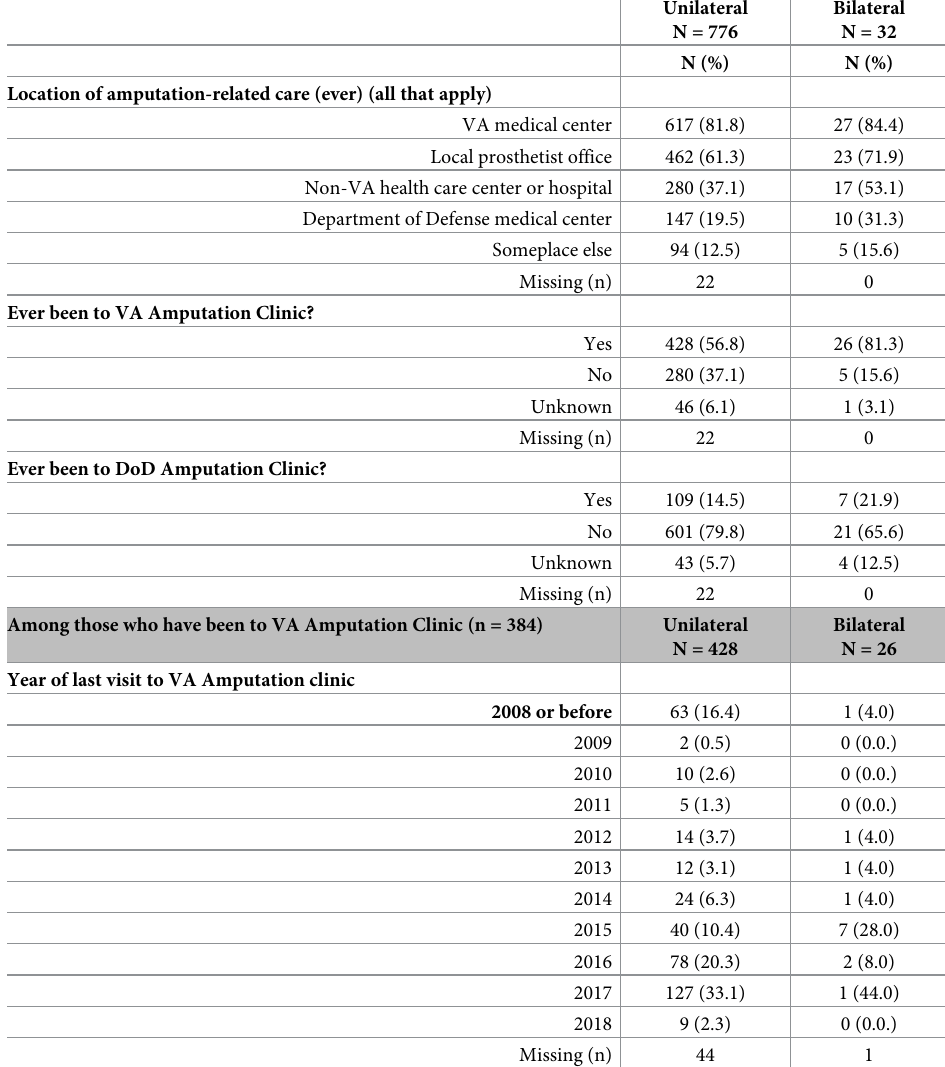
Unilateral Bilateral N = 776 N = 32 N (%) N (%)